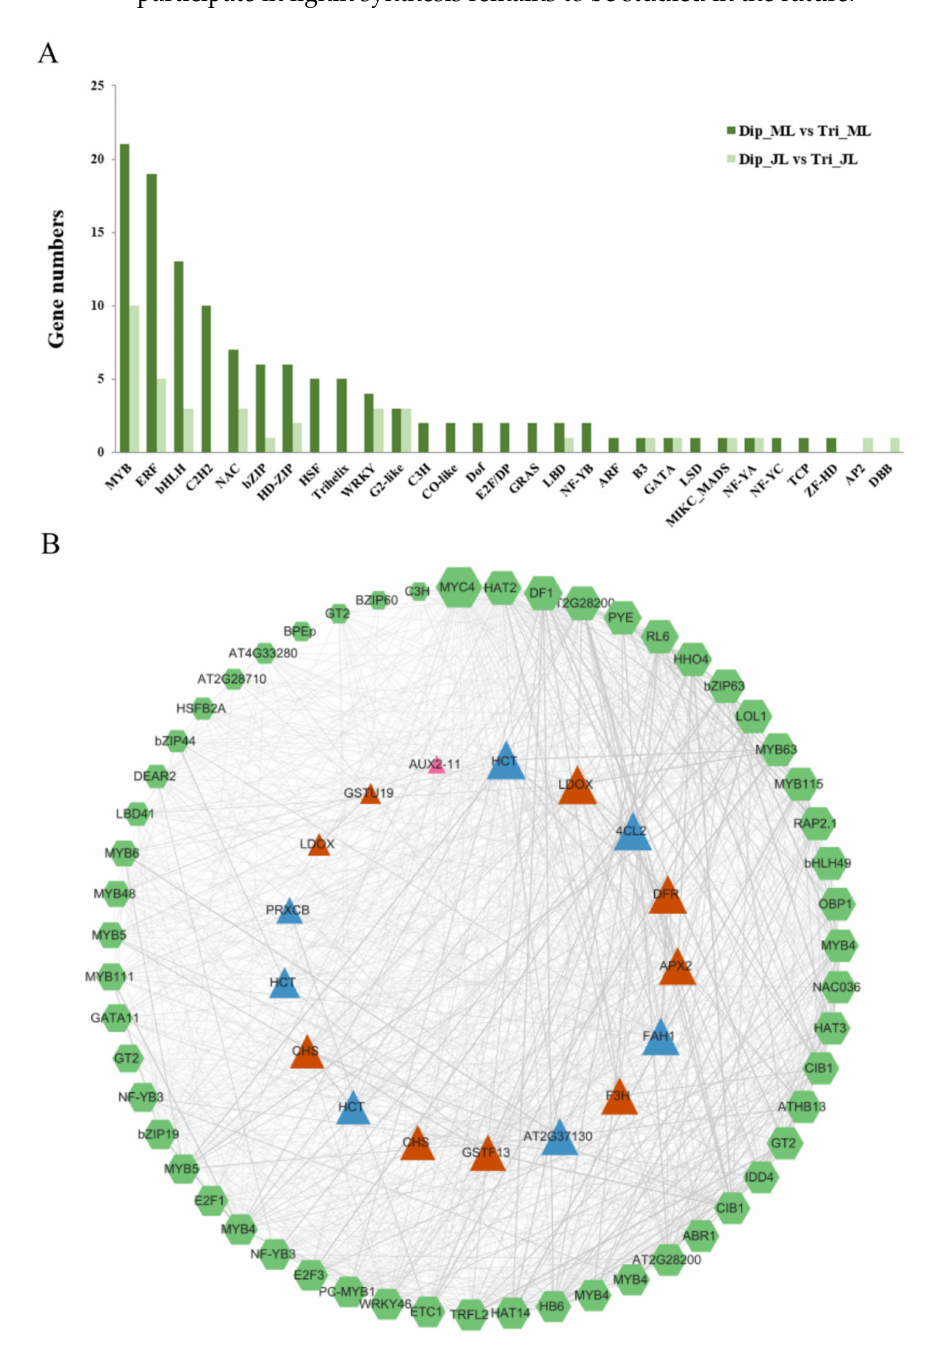
Figure 6. Analysis of differentially expressed transcription factors (TFs). ( A ) The distribution of differentially expressed TFs in juvenile and mature leaves. ( B ) Co-expression network between structural genes (SGs) and TFs. Green hexagonal nodes represent TFs. Triangular nodes represent SGs, of which blue nodes are lignin structural genes, brown nodes are genes related to stress resistance, and pink nodes are genes related to cell growth. The node size is positively correlated with the gene degree. The width of the connecting line is positively related to the correlation between genes. Dip_JL, juvenile diploid leaves; Dip_ML, mature diploid leaves; Tri_JL, juvenile triploid leaves; Tri_ML, mature triploid